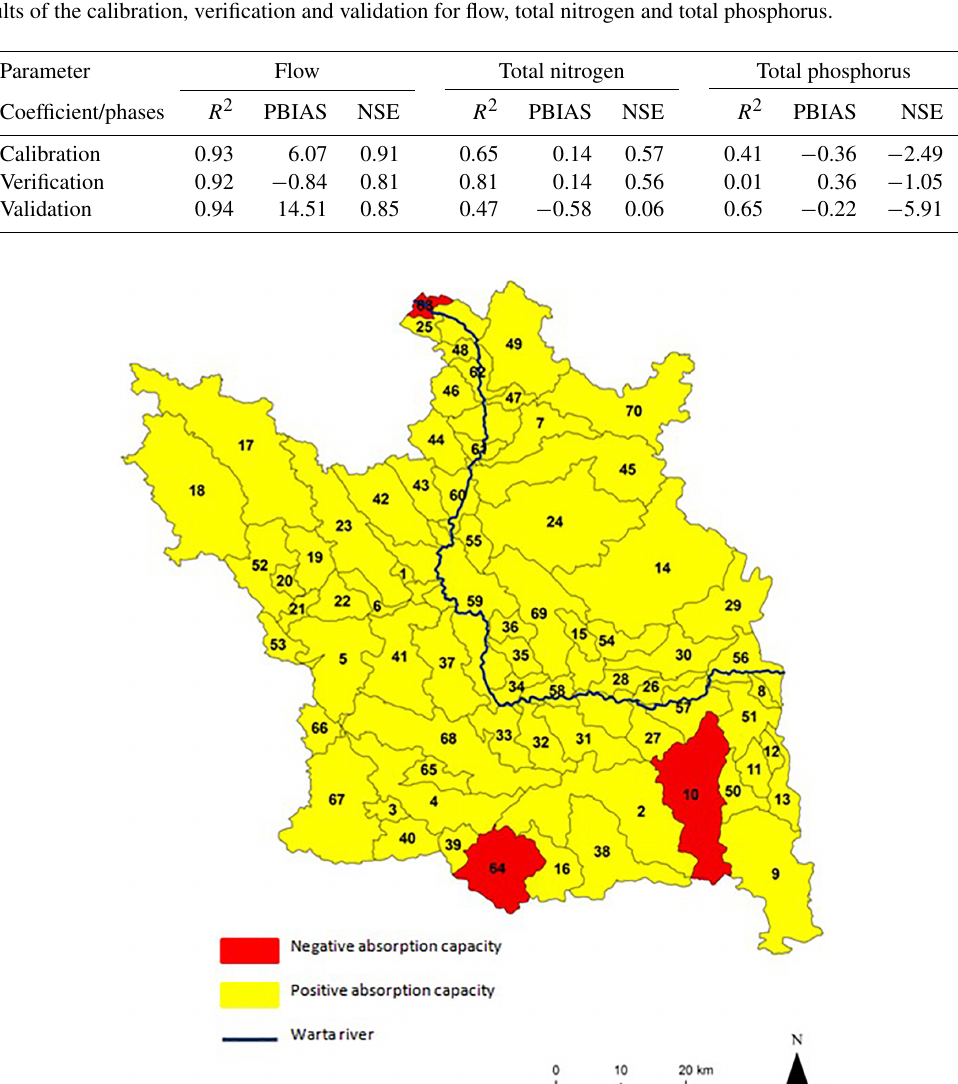
Figure 8. Actual absorption capacity for each water body of the Middle Warta for total nitrogen based on characteristic flow